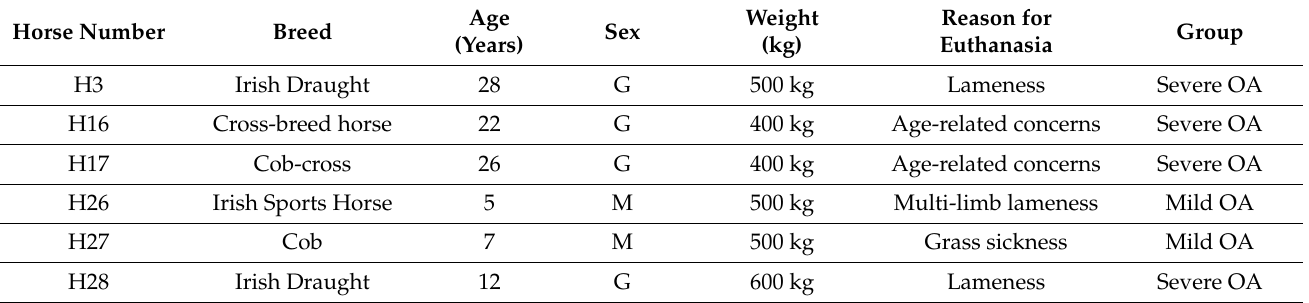
Table 2. Details of the donor horses used for cartilage collection and monolayer cell